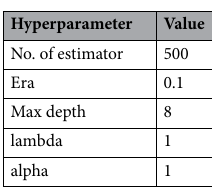
Table 1. Hyperparameters of the proposed